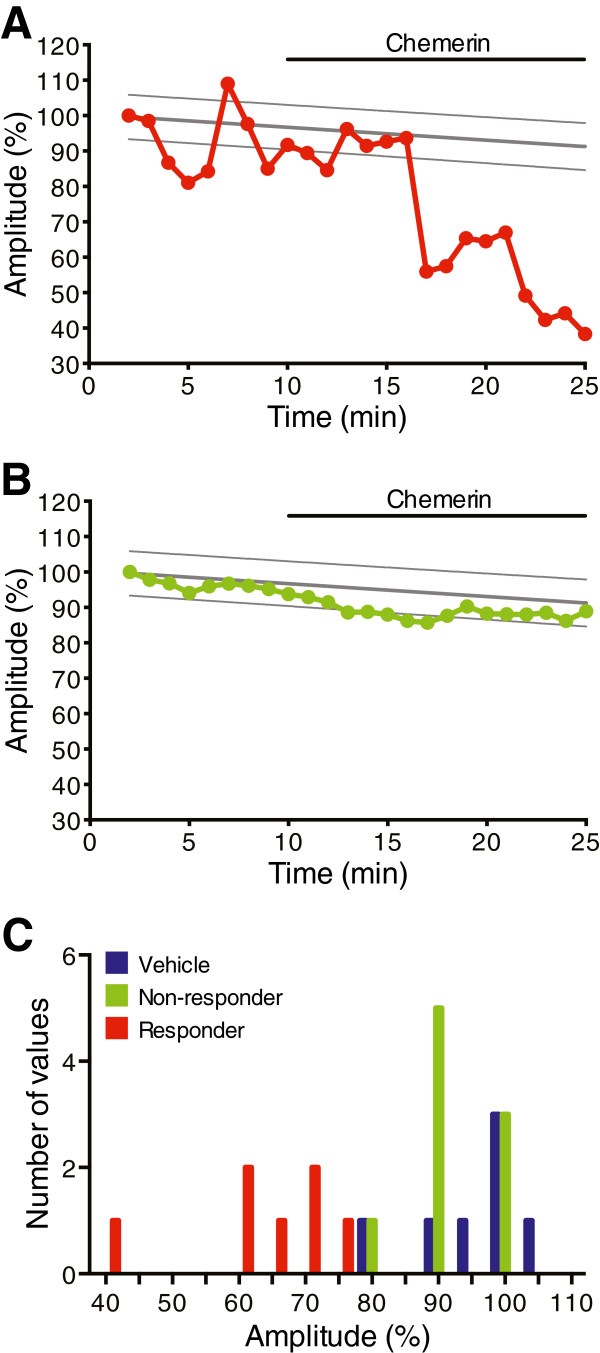
Identification of a subpopulation of chemerin-responsive lamina I NK1R+ neurons. A. Example of a neuron classified as a chemerin responder, because the peak amplitude of the C-fibre eEPSCs falls below the lower 95% prediction band (95% prediction bands designated by the upper and lower grey lines) for at least the final 5 mins of chemerin (100 ng/ml) application. B. Example of a lamina I NK1R+ neuron classified as a chemerin non-responder because the peak amplitude of the C-fibre eEPSCs largely falls within the 95% prediction bands. C. Frequency histogram of the normalised mean eEPSC peak amplitude during the final 5 mins, demonstrating that the distribution of the responses of chemerin responders does not overlap with either the non-responder or vehicle groups.